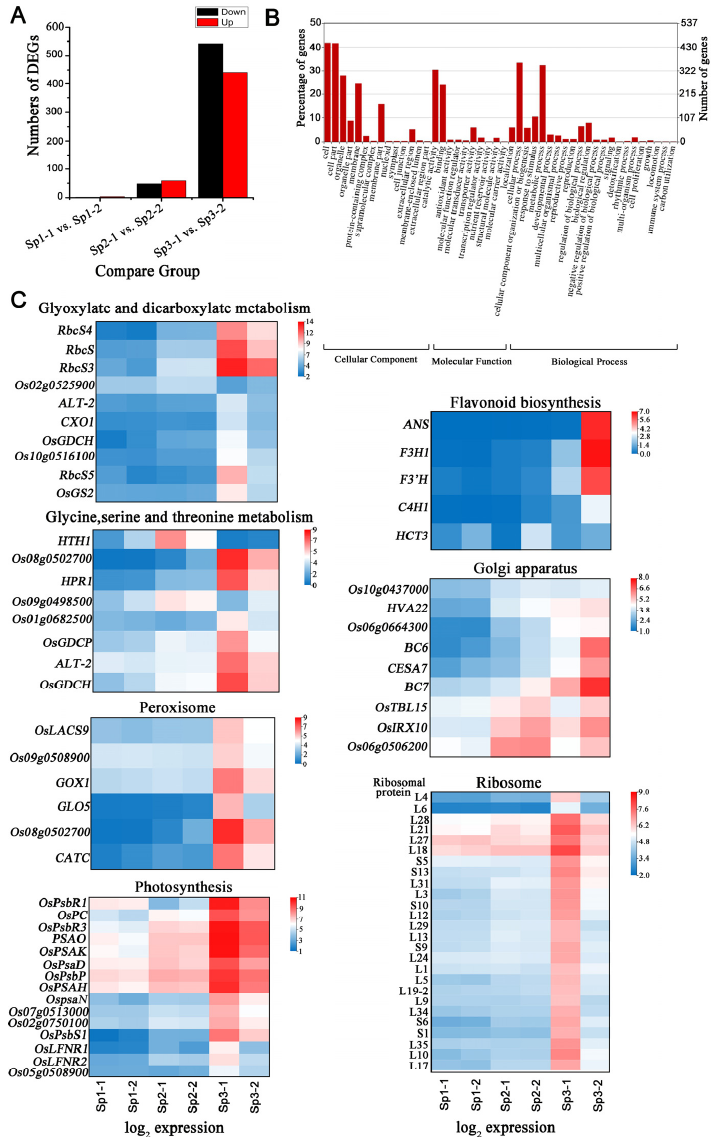
Figure 8. Analysis of genes differentially expressed in hybrids F 1 ( ORF4 +/ ORF4 +) compared with hybrids F 1 ( ORF4 +/ ORF4 − ). ( A ) Number of the up- and down-regulated DEGs of hybrid F 1 in different genotypes of ORF4 . ( B ) The significant GO annotations of DEGs during three spikelet development stages. ( C ) Heat map of expression change of genes selected in the DEGs. The color in each frame represents the level of expression change based on the log 2 fold. Sp1-1 and Sp1-2 indicated the florets in length ranges of 3.0–4.5 mm of the hybrid F 1 from 04-06/10-06 and 14-06/10-06 respectively; Sp2-1 and Sp2-2 indicated the florets in length ranges of 10.2–11.5 mm of the hybrid F 1 from 04-06/10-06 and 14-06/10-06 respectively; Sp3-1 and Sp3-2 indicated the florets one day before heading of the hybrid F 1 from 04-06/10-06 and 14-06/10-06